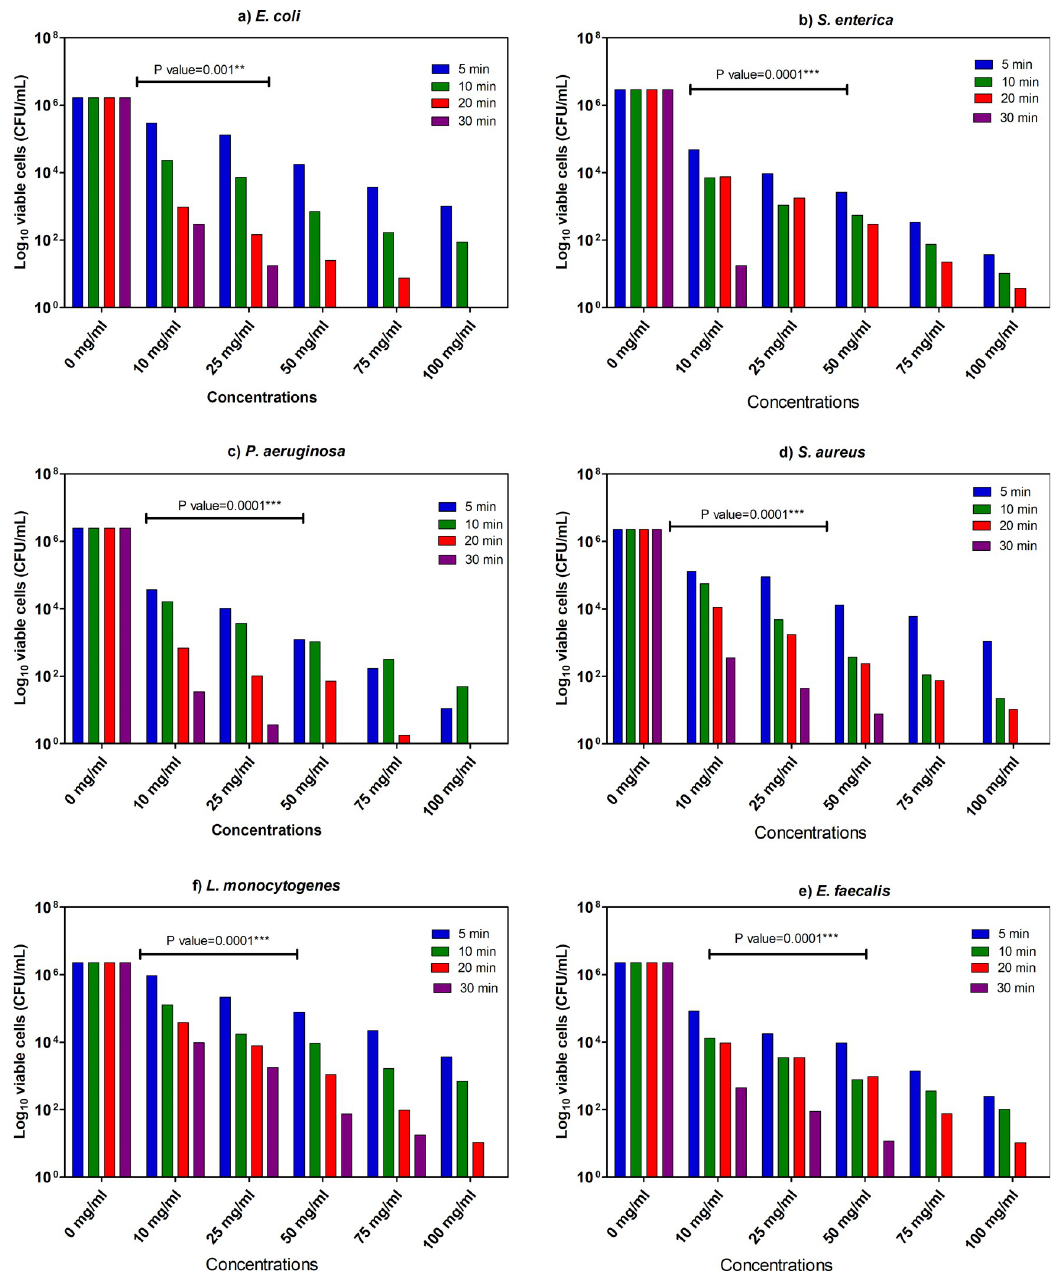
Fig 4. MIC (Minimum inhibitory concentration) values of plant leaves methanol extract of M . azedarach L. towards examined bacterial species. The remaining viable cell populations at various time intervals of 5, 10, 15, and 30 minutes are also shown. Two-way analysis of variance ( ANOVA ) states �� indicates moderate correlation ( p � 0.01), ��� indicates high correlation ( p � 0.001).